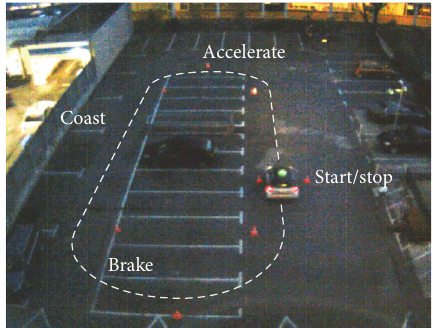
Figure 18: Oval maneuver combined